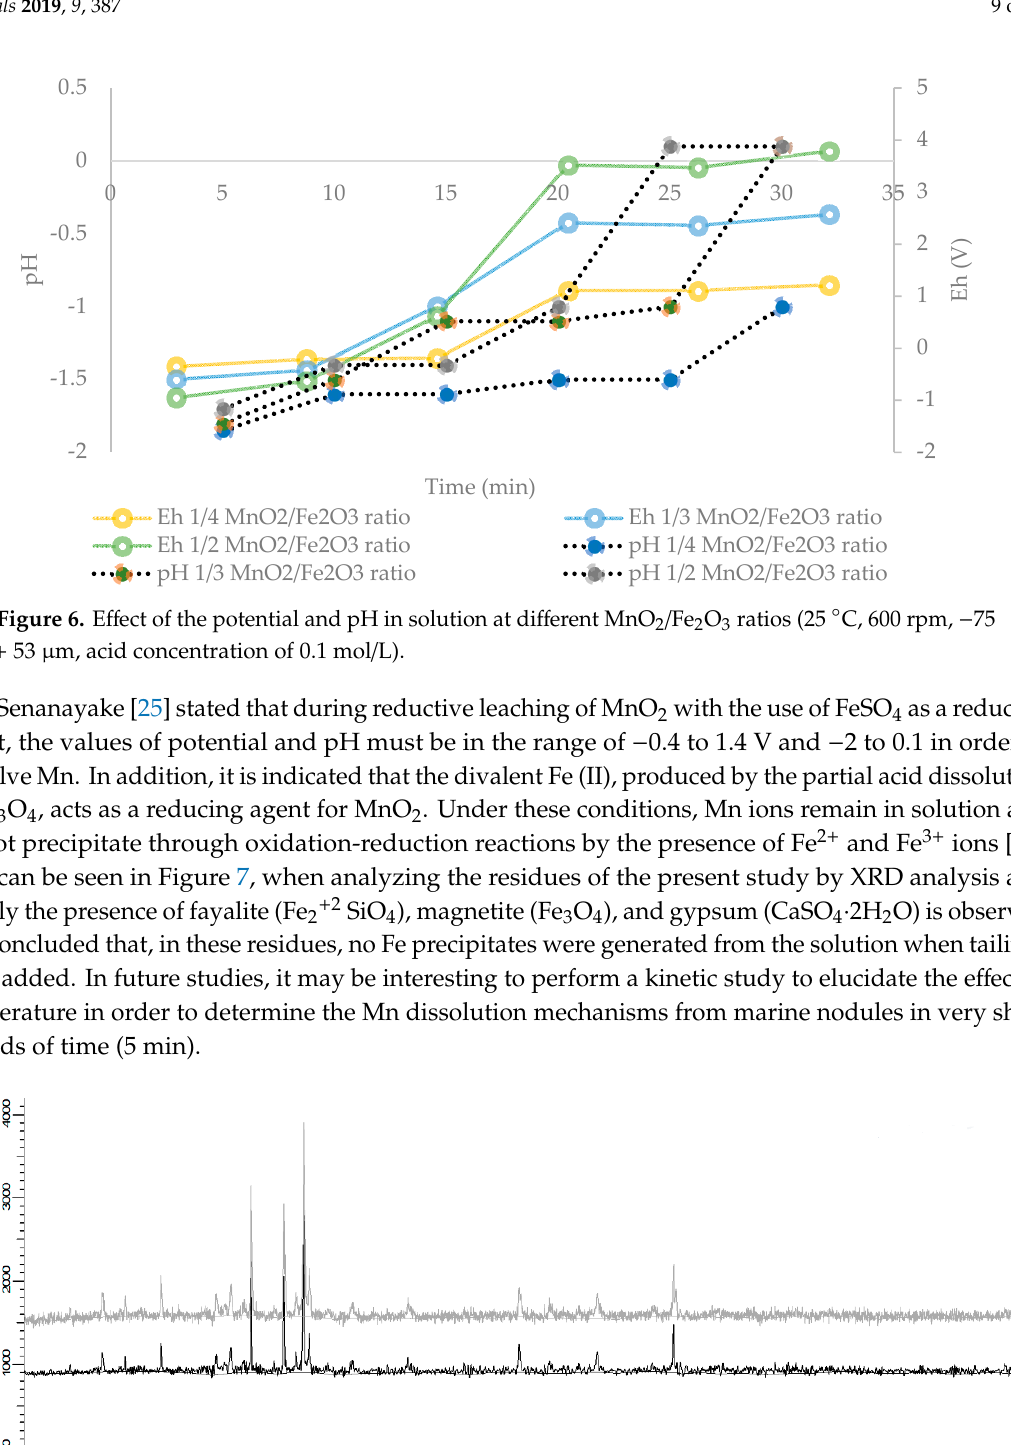
Figure 7. X-ray diffractogram of solid waste after leaching for 30 min at 25 °C using a MnO 2 /Fe 2 O 3 ratio of 1:2, 600 rpm, − 75 + 53 μ m, and an acid concentration of 0.1 mol/L.